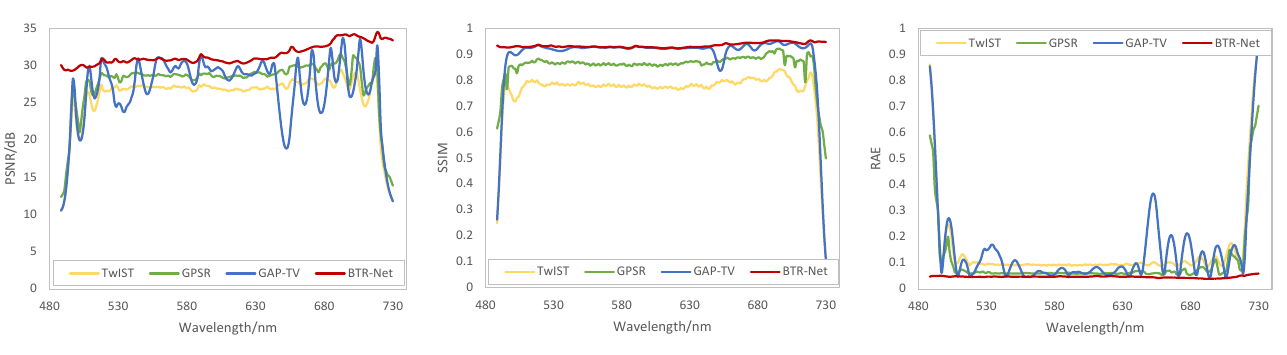
Figure 6. Performance of BTR-Net and iterative algorithms at different wavelengths, taking PSNR ( left ), SSIM ( middle ) and RAE ( right ) as evaluation metrics.